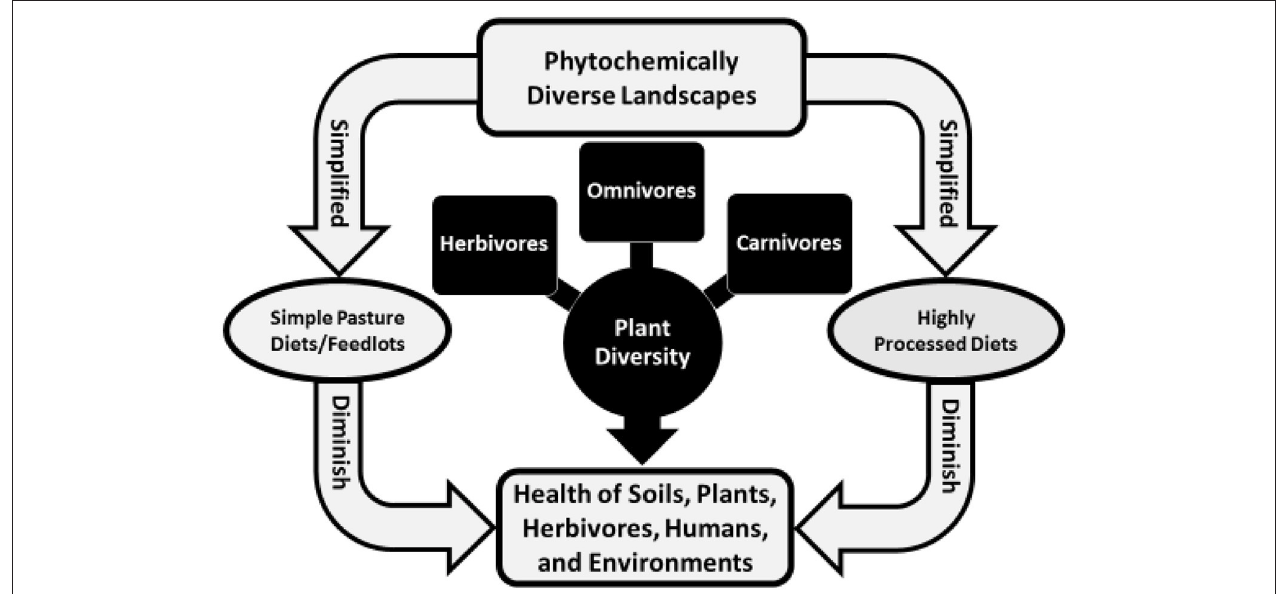
FIGURE 1 | The health of life in soils, plants, herbivores, humans, and environments (land, water, and air) is tied to plant diversity—phytochemical richness—across